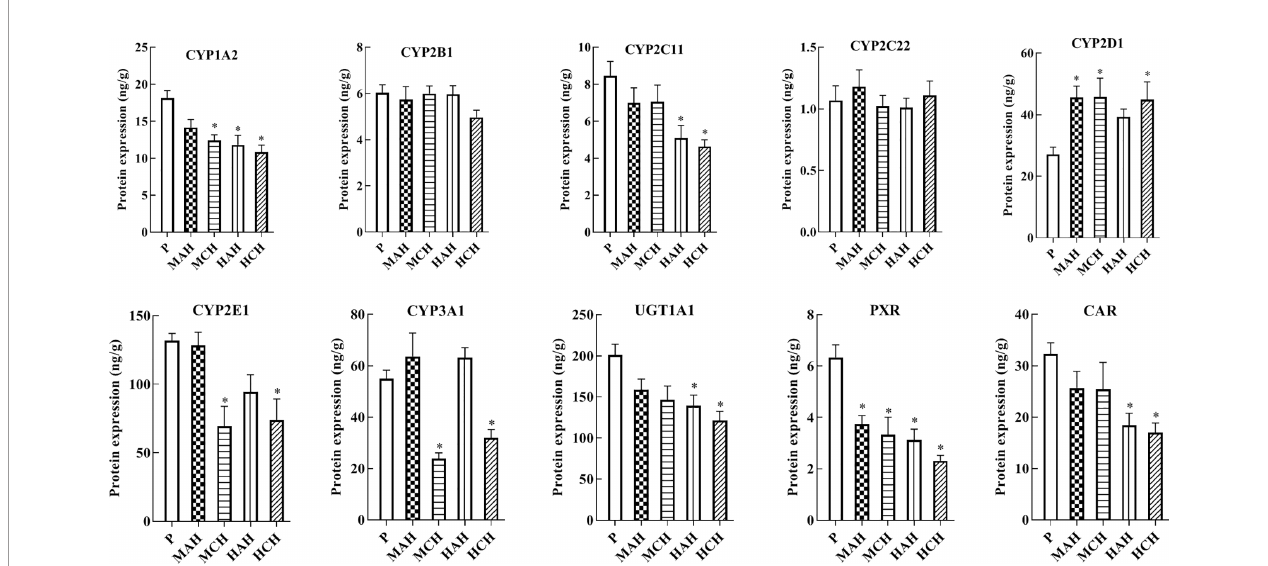
FIGURE 2 | Protein expression of CYP1A2, CYP2B1, CYP2C11, CYP2C22, CYP2D1, CYP2E1, CYP3A1, UGT1A1, PXR, and CAR in rats. P: plain group (altitude: 390 m, PaO 2 : 20 kPa), MAH: acute moderate-altitude hypoxia group (altitude: 2,800 m, PaO 2 : 15.1 kPa; Rats were exposed to moderate altitude for 24 h), MCH: chronic moderate-altitude hypoxia group (altitude: 2,800 m, PaO 2 : 15.1 kPa; Rats were exposed to moderate altitude for 30 days), HAH: acute high-altitude hypoxia group (altitude: 4,300 m, PaO 2 : 12.4 kPa; Rats were exposed to high altitude for 24 h), HCH: chronic high-altitude hypoxia group (altitude: 4,300 m, PaO 2 : 12.4 kPa; Rats were exposed to high altitude for 30 days). The data were analyzed using a one-way analysis of variance (ANOVA), and the differences between the means of two groups were compared using LSD tests. * indicates the signi fi cance of experimental groups, compared with that of the control. Values are expressed as Mean ± SEM (n = 10). Levels are considered signi fi cant at * p < 0.05.